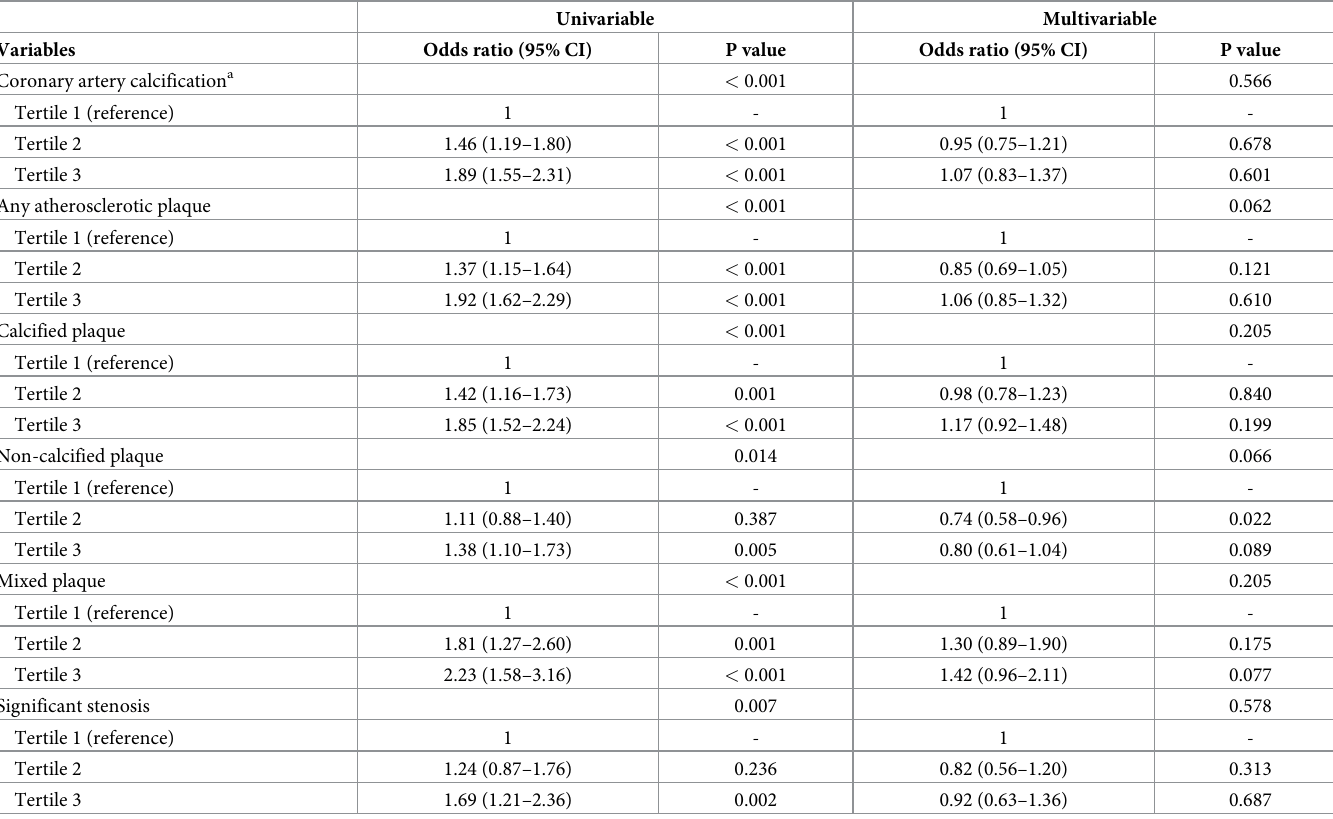
Table 3. Association between homocysteine levels and coronary computed tomography angiographic